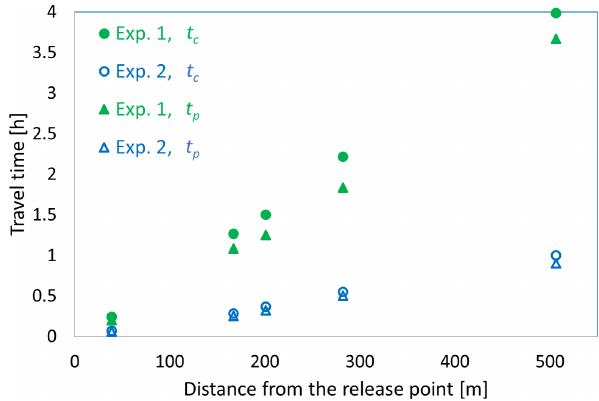
Figure 8. Centroid t c and peak travel time t p during the experiments in vegetated (Exp. 1) and fully cut (Exp. 2)